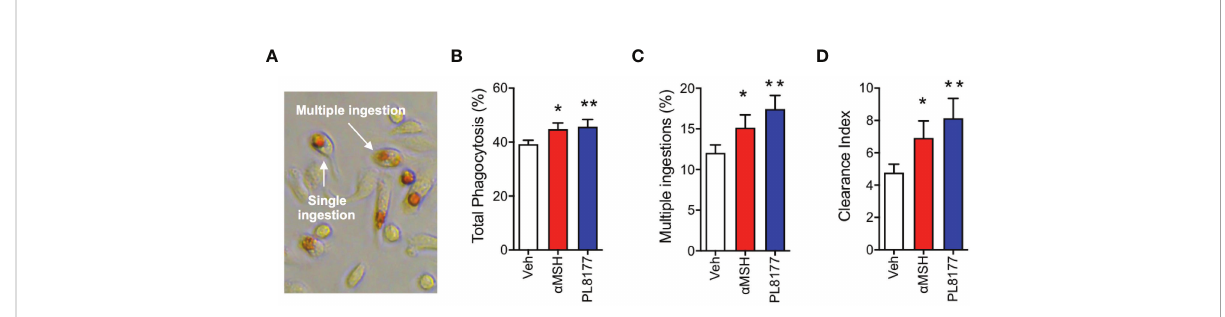
FIGURE 4 Pro-resolving effects of PL8177 on Macrophage efferocytosis. Biogel-elicited peritoneal macrophages were incubated with Melanocortin compounds (2 m M) for 30 min prior to the addition of apoptotic neutrophils (at a Macrophage:neutrophil ratio of 1:5). After 1 h, cells were stained using the myeloperoxidase (MPO) assay to visualize ingested neutrophils. (A) Representative image shows the dark brown coloration selectively acquired by engulfed neutrophils. An example of single and a multiple ingestion are indicated. (B) Total phagocytosis was calculated as % of macrophages containing at least one neutrophil inside. (C) Multi-phagocytic cells containing more than 1 neutrophil were also quanti fi ed. These data show the percentage of macrophages that have ingested more than one neutrophil, with respect to the total Macrophage population (D) Clearance Index was calculated as (% phagocytic cells x % multiple ingestions) x100. Data represent mean ± SEM of 5 mice analyzed by repeated measures one-way ANOVA followed by multiple comparison test. * p <0.05, **p<0.01 vs. untreated (Veh).